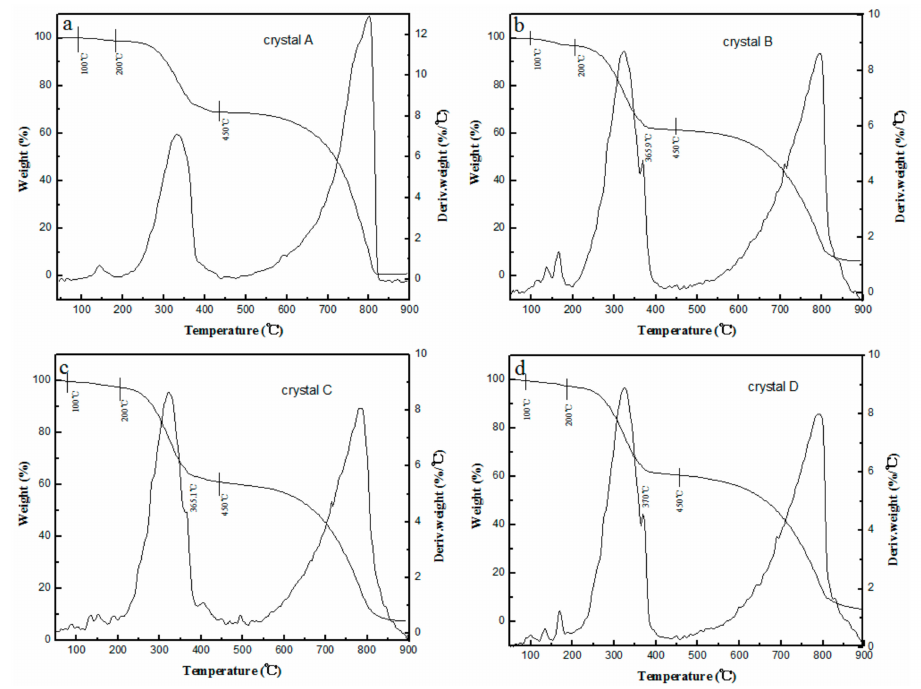
Figure 4. TG/DTG thermograms for the crystals. ( a ) crystal A; ( b ) crystal B; ( c ) crystal C; ( d ) crystal D.